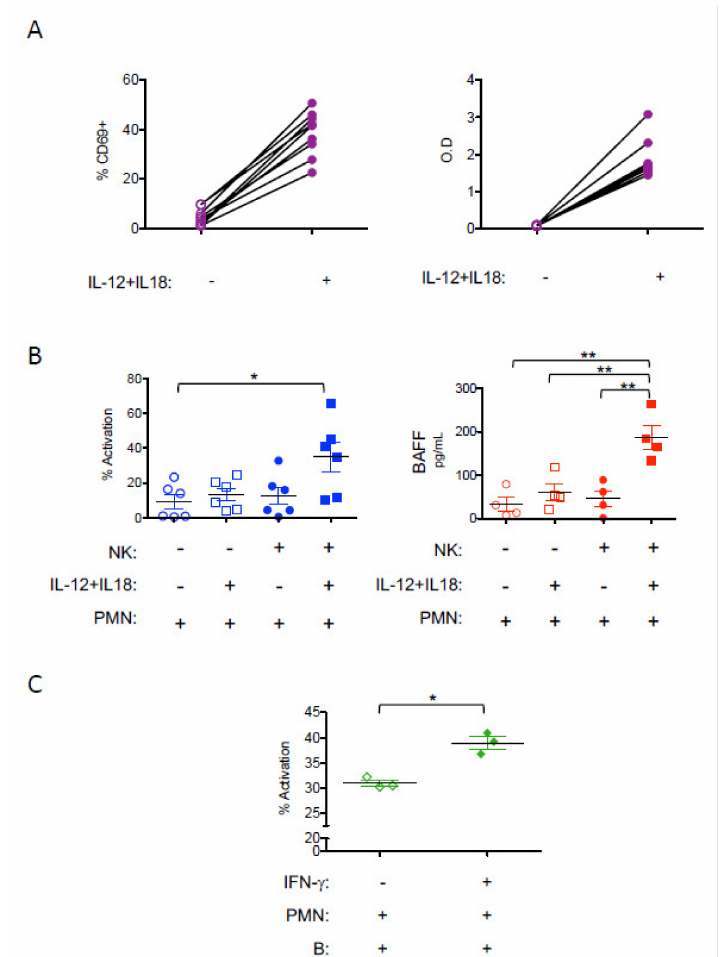
Figure 6. Effect of NK-derived IFN- γ in the enhancement of the B-cell helper function of neutrophils. NK cells from naïve mice were isolated and activated in vitro with IL-12 and IL18 and further used for co-culture experiments with neutrophils (PMN): ( A ) activation of NK cells by IL-12 and IL18, assessed by the upregulation of CD69 molecule ( n = 8 independent experiments) and the secretion of IFN- γ ( n = 9 independent experiments); ( B ) activation (increase in CD11b expression) and B-cell activating factor (BAFF) secretion capacity of neutrophils isolated from naïve mice co-cultured with IL-12 /IL18-activated NK cells ( n = 6 for phenotype and n = 4 for BAFF secretion); ( C ) activation of B cells (transition of IgD + IgM − to IgD + IgM + or IgD+ + IgM + to IgD − IgM + ) isolated from naïve mice co-cultured with IFN- γ -activated neutrophils. The data correspond to 3 independent experiments (* p < 0.05; ** p <